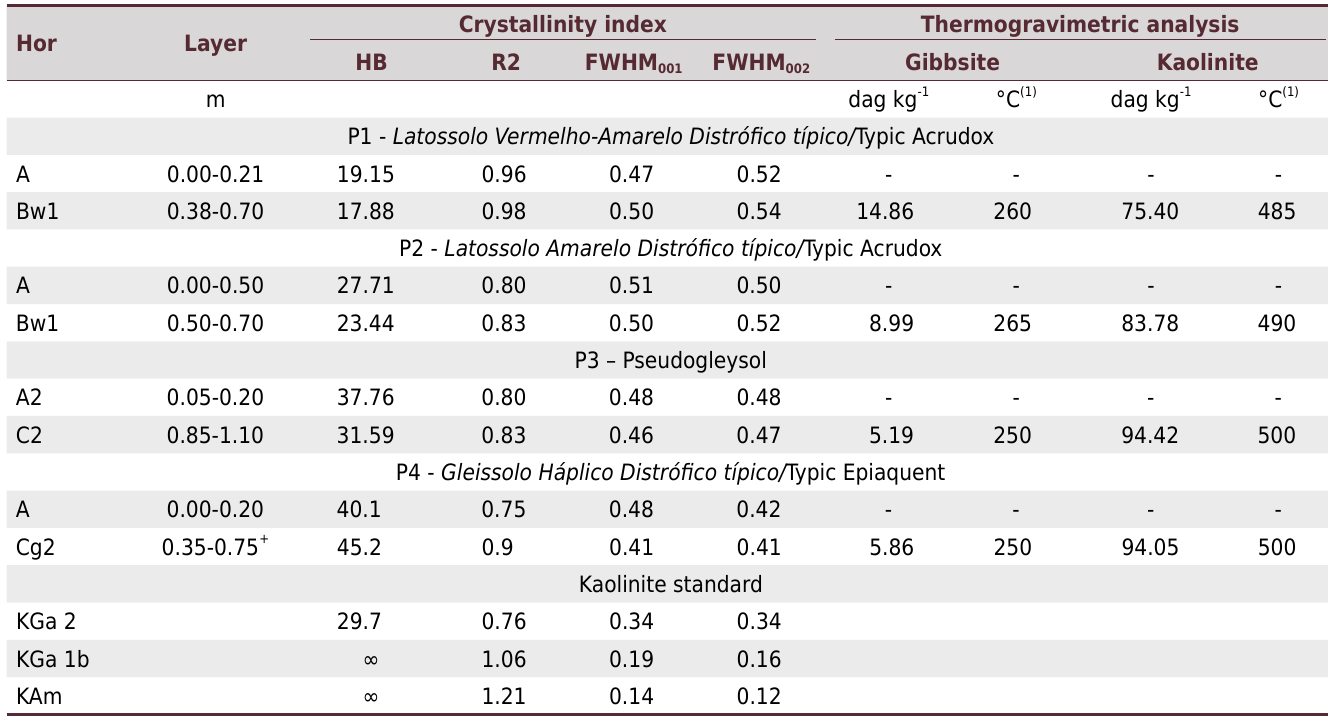
Table 4. Kaolinite crystallinity index and Thermogravimetric analysis (TGA) Hor